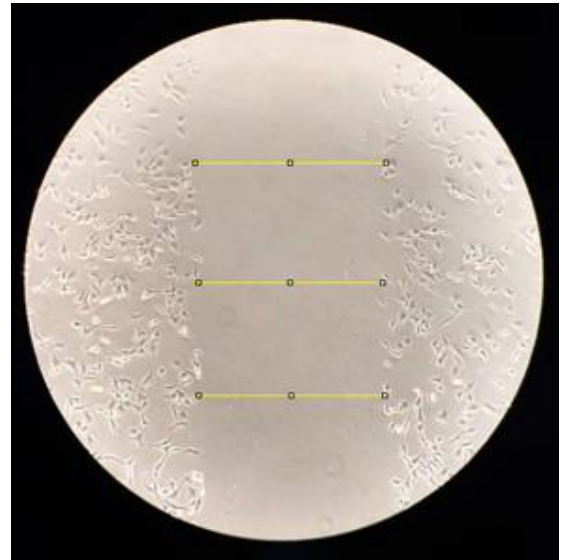
Figure 1. Measures to determine the width after scratch .